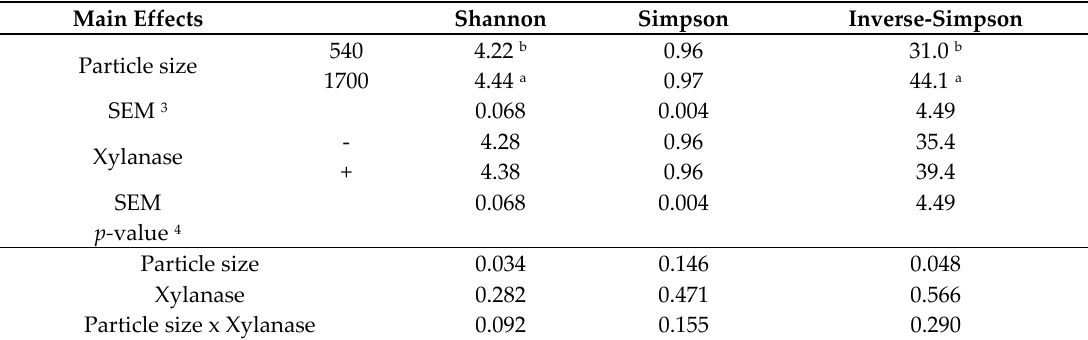
Table 9. Effects particle size 1 and xylanase inclusion in alpha diversity on 21-day cecal microbiota 2